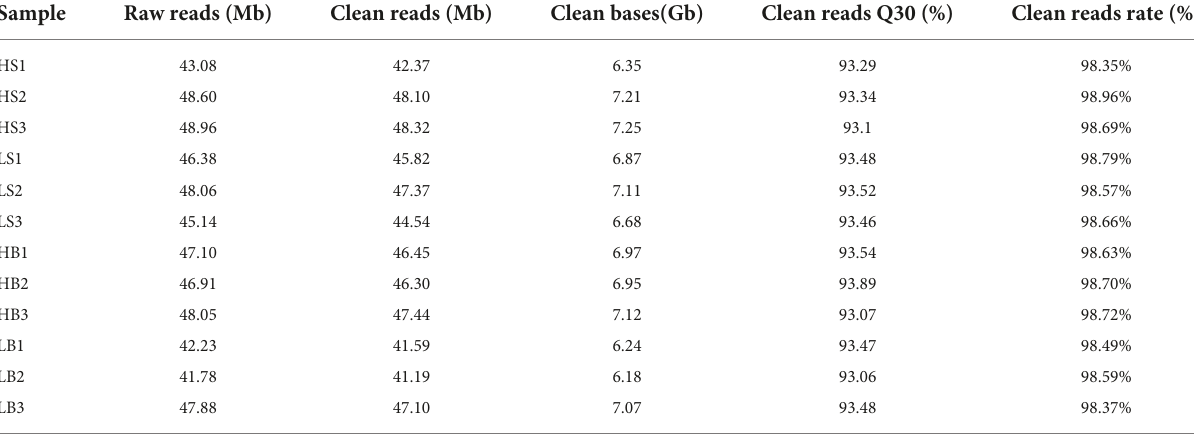
TABLE 1 Illumina HiSeq of H. ammodendron and H. persicum , including three repetitions under humid (HS1, HS2, HS3 and HB1, HB2, HB3) and arid (LS1, LS2, LS3 and LB1, LB2, LB3) environments.